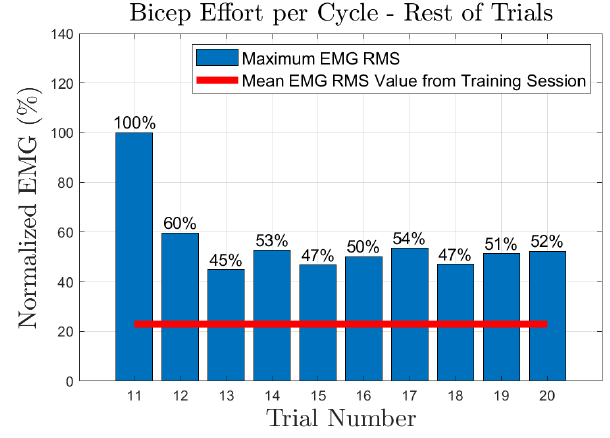
Figure 24. Subject 5: Flexion sEMG RMS values per